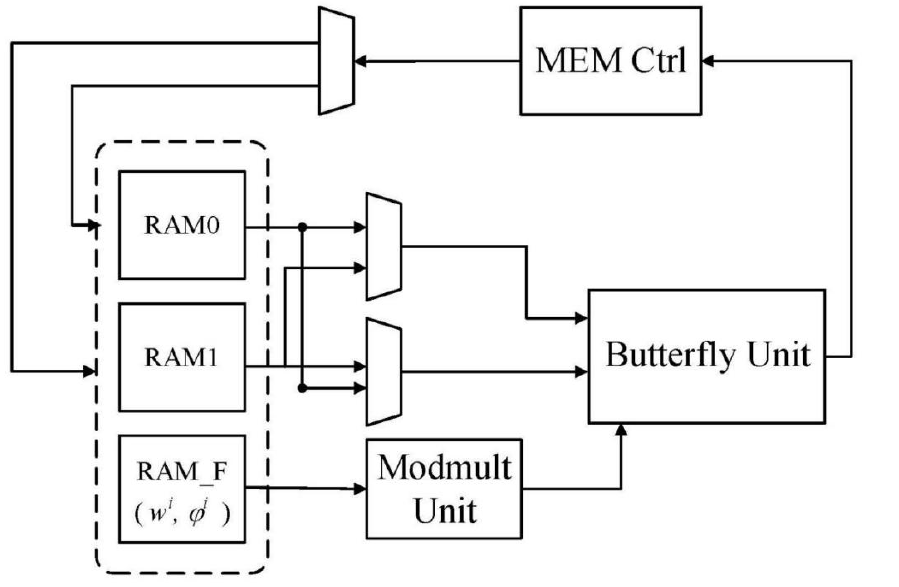
Figure 2. L-NTT module hardware